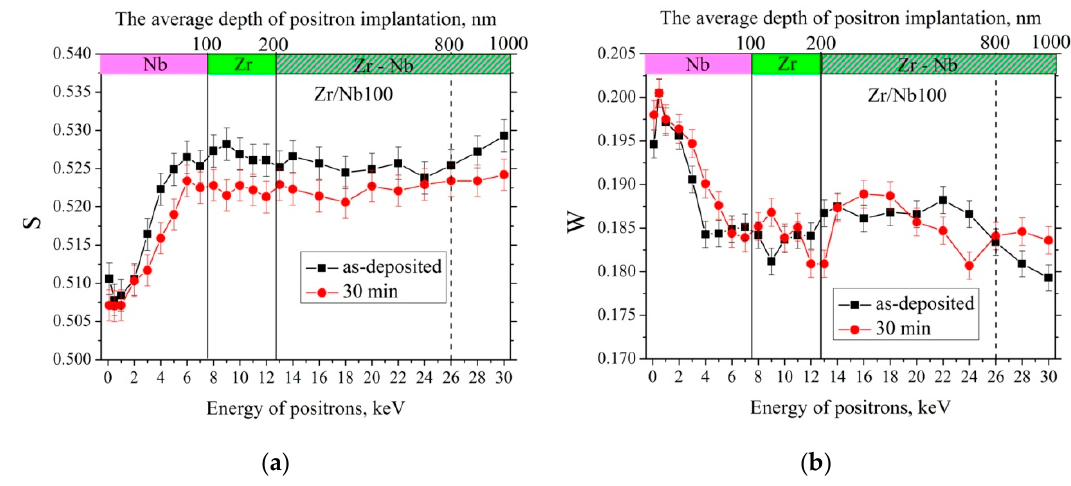
Figure 9. DBS-VEP depth profile of the S ( a ) and W ( b ) parameters for Zr/Nb 100. The S parameter stands for positron annihilation with low momentum electrons (it increases with defects concentration and is higher for Zr than Nb), and W is responsible for positron annihilation with high momentum electrons.